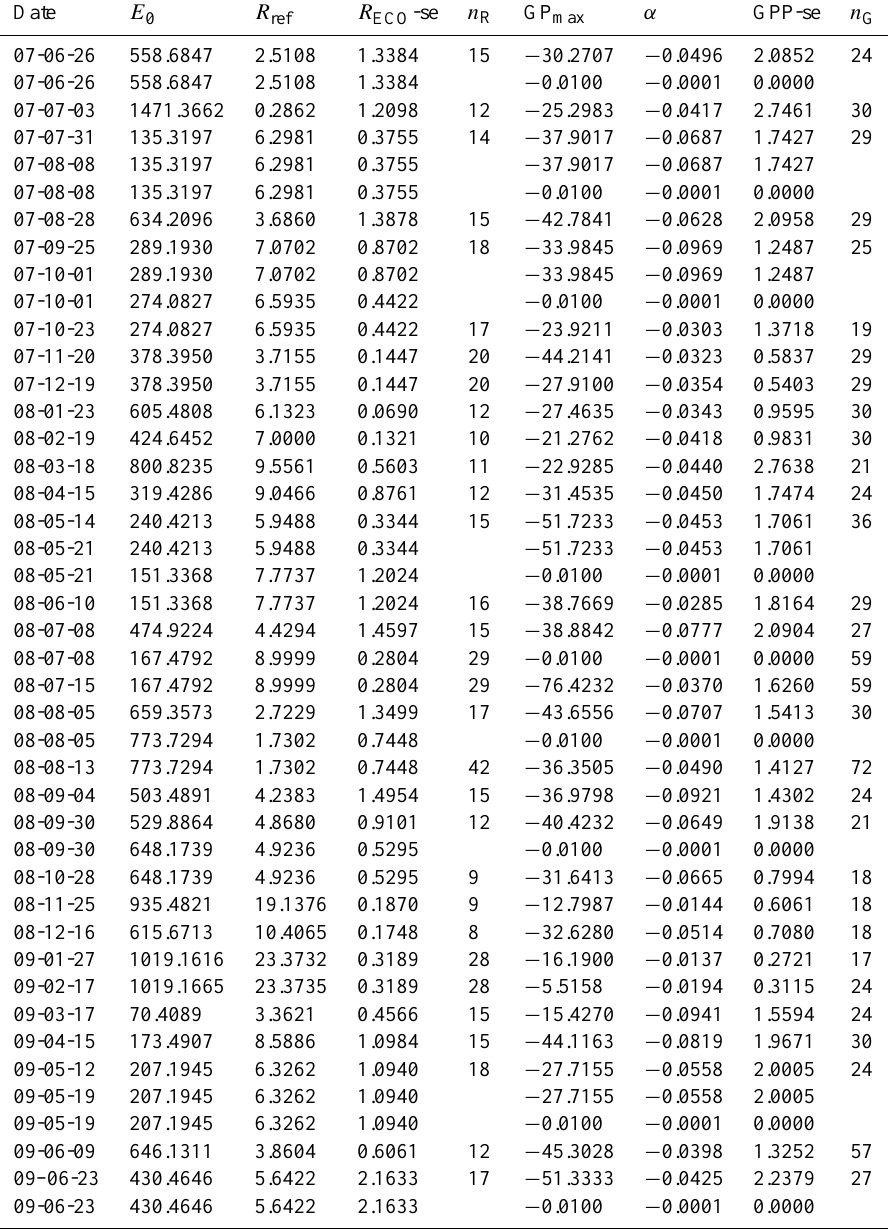
Table A1. Model parameters of the intensively used grassland site (GI). Note the reset of GP max to 0.01 and α to 0.0001 after every cut. E 0 , R ref , GP max and α indicate the activation energy-like parameter (K), the reference temperature (K), highest possible production rate at infinite PAR (mgCO 2 –Cm − 2 h − 1 ) and initial slope of the regression curve ((mgCO 2 –Cm − 2 h − 1 )/(µmolm − 2 s − 1 )), respectively. “ R ECO - se”, “GPP-se”, “ n R ” and “ n G ” display the standard error for the daily R ECO model, the standard error for the daily GPP model, the number of measurements for R ECO (with opaque chambers, see Sect. 2.2), and the number of measurements for GPP (with transparent chambers, see Sect. 2.2), respectively. Interpolated or reset values do not possess a number of